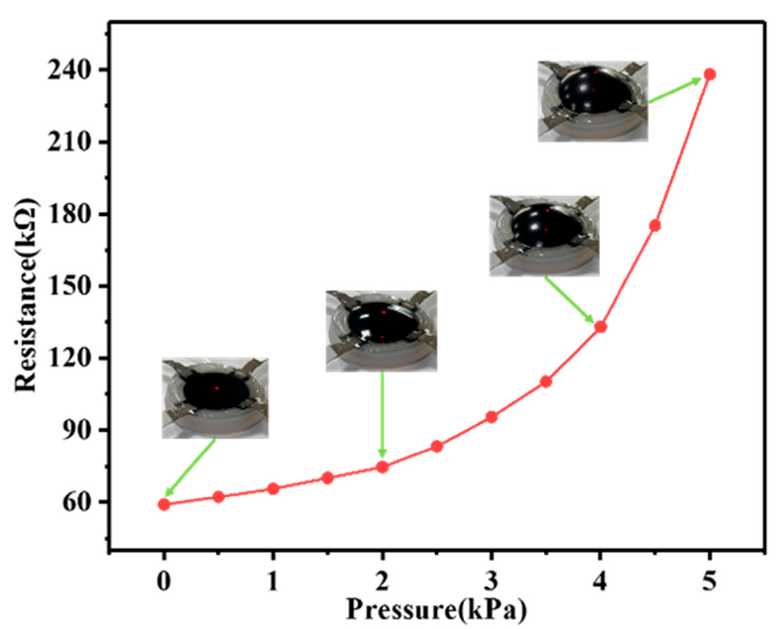
Figure 9. Peak resistances (derived from Figure 8) and the corresponding deformation states of SHEPA are shown in the insets.